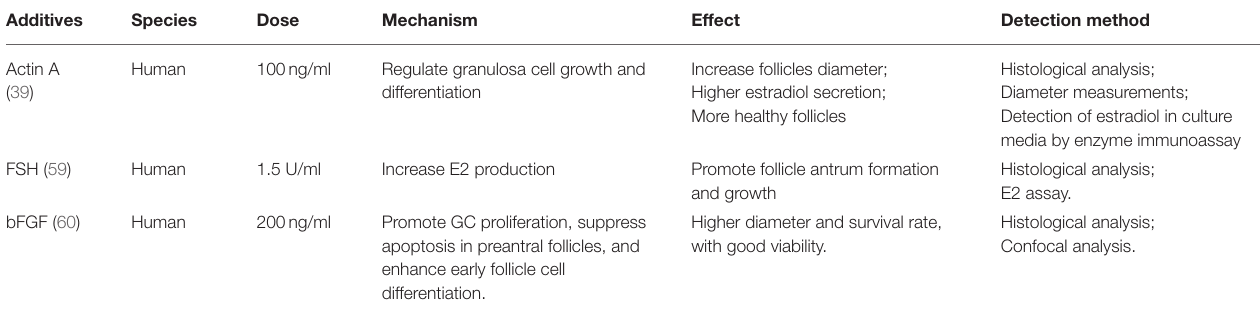
TABLE 2 | Reported additives in human follicle in vitro growth